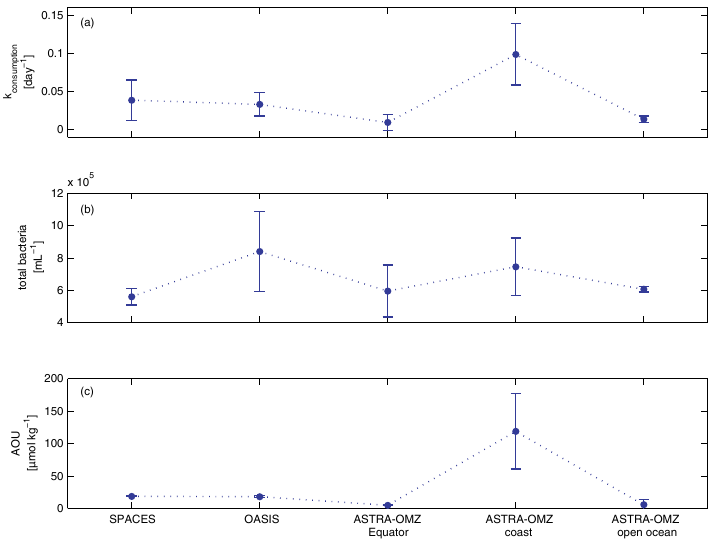
Figure 10. Mean values ( ± SD) for (a) k consumption (day − 1 ), (b) total bacteria counts (mL − 1 ), and (c) AOU (µmolL − 1 ) during SPACES, OASIS, and ASTRA-OMZ (split into three different parts: Equator, coast, and open